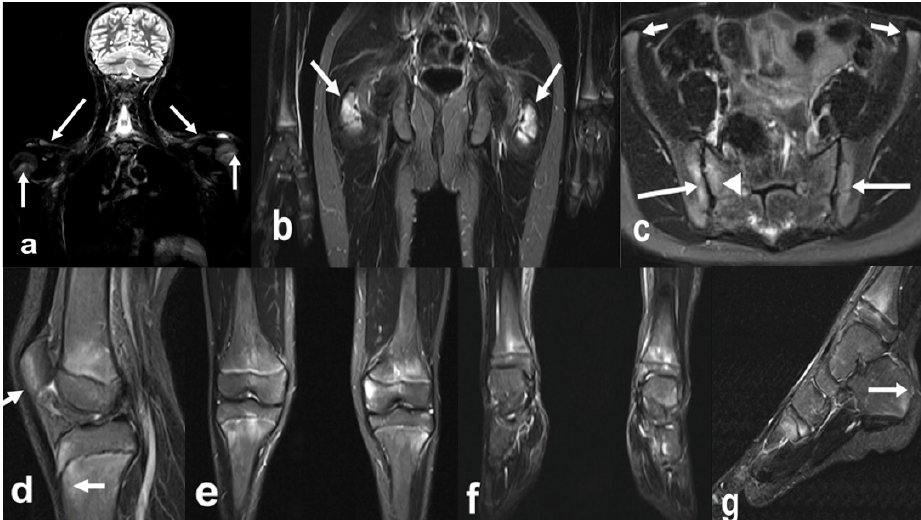
Figure 7. Whole-body MRI (WBMRI) in a 12-year-old boy with enthesitis-related arthritis (ERA) subtype of juvenile idiopathic arthritis (JIA). Superposition of findings of ERA and chronic recurrent multifocal osteomyelitis (CRMO) is seen on this WBMRI examination with STIR images of multiple body parts in multiple directions ( a – g ). Findings of CRMO are presented by ill-defined flamed-shaped areas of increased inversion recovery (IR) signal seen in the bilateral proximal humeral metaphyses and distal clavicles ( a , arrows), distal femoral and proximal tibial metaphyses and at a lesser extent, epiphyses ( d , e ), distal tibial metaphyses and epiphyses, and tarsal and proximal metatarsals ( g ). Findings of JIA-related enthesopathies are represented by IR signal noted in the bilateral greater trochanters ( b , arrows) at the site of insertion of gluteus medius and minimus, along the sacroiliac joints ( c ), iliac, long arrows and sacral aspects, arrowhead; ( c ), normal anterior–superior iliac spine apophyses short arrows), proximal and distal attachments of patellar tendon ( d , arrows), and at the insertion of the Achilles tendon in the posterior calcaneus ( g ,